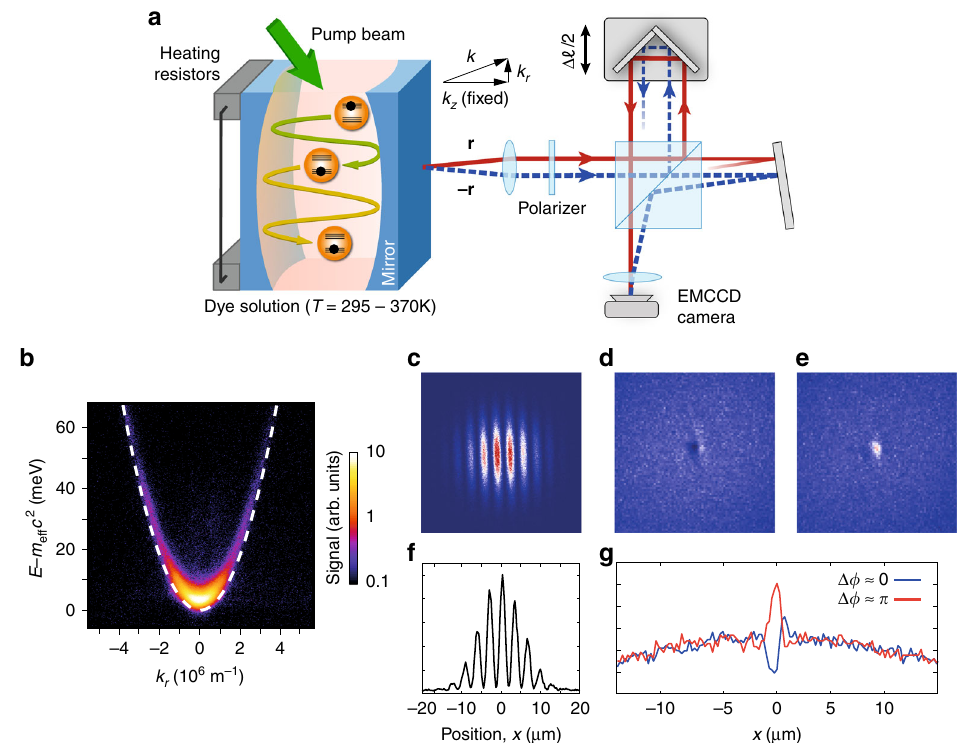
Fig. 1 Experimental scheme. a The dye- fi lled optical microcavity con fi nes photons between two highly re fl ecting mirrors spaced in the wavelength regime, where they thermalize to the temperature of the dye solution by absorption re-emission processes. The ambient temperature of the apparatus can be varied between 297 K (room temperature) and 370 K. The Michelson interferometer shown on the right is used to investigate the transverse and longitudinal coherence of the photon gas. The sketched axial mirroring of transverse coordinates illustrates the actual point mirroring in the image plane done by the cat-eye retrore fl ector. b Measured dispersion of the dye microcavity emission, showing photon energies vs. the transverse wave vector k r (derived from the angle of emission). The data were recorded for the uncondensed gas. c – g Camera images of the radiation transmitted by the interferometer in the condensed ( c ) and in the uncondensed ( d , e ) phase regime, with N/N c ≈ 1.76 and N/N c ≈ 10 − 4 , respectively. In the uncondensed phase, the transverse coherence length of the microcavity emission is so short that it amounts to less than a fringe width. The two camera images correspond to two different relative path lengths in the Michelson interferometer. The image size corresponds to 40 µ m×40 µ m ( c ) and 20 µ m×20 µ m ( d , e ), respectively. The bottom plots ( f ) and ( g ) give cuts through the center of the corresponding fringe patterns ( c ) and ( d , e ),